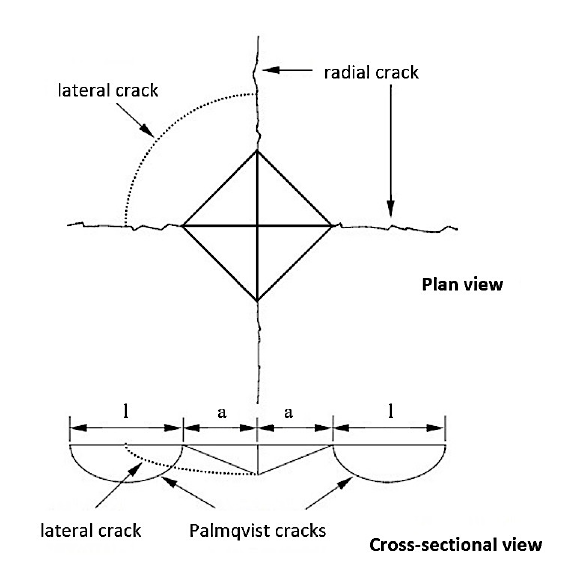
Figure 1. Palmqvist and lateral crack systems (adapted from